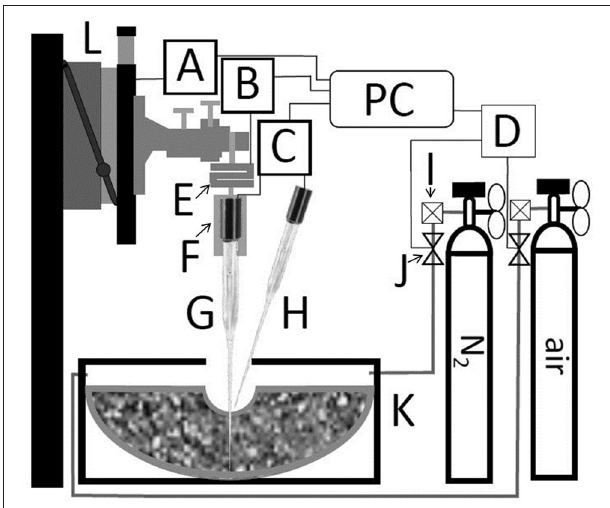
FIGURE 2 | Schematic representation of coupled measurement of penetration resistance and either oxygen diffusivity or oxygen distribution. Motorized micromanipulator (L) with motor driver (A). S-shaped force sensor (E) with A/D-converter (B). Customized mount (F) with electrode 2 (G) placed in soil. Electrode 1 (H) placed at soil surface. Both electrodes were connected to UniSense multimeter (C). Microcontroller board (D) controlled magnet valves (J). The outflow of gas bottles is regulated with flowmeter (I). (A), (B), (C), and (D) are connected to a personal computer (PC) with UniSense software controlled by self-developed